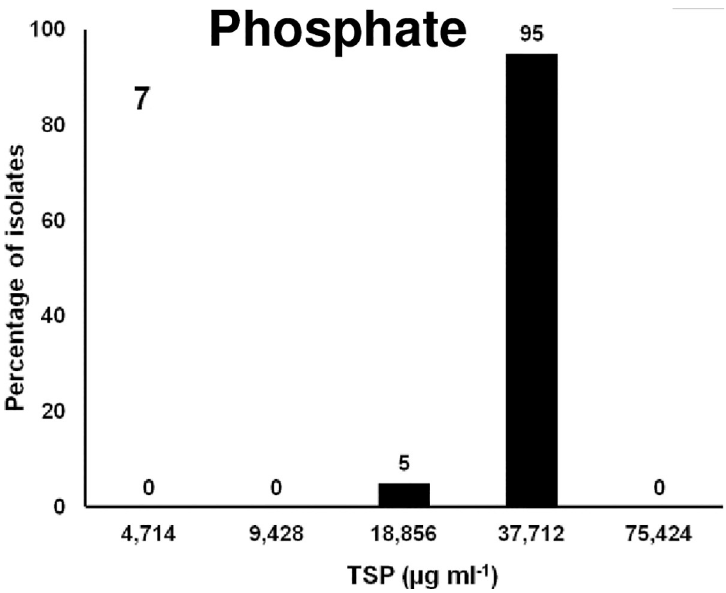
Fig 7. Frequencies of the MICs of 88 MDR Salmonella isolates to phosphate compound Trisodium phosphate, TSP. X-axis is the 2-fold increase of biocide concentration; y-axis is percentage of isolates susceptible at each concentration of